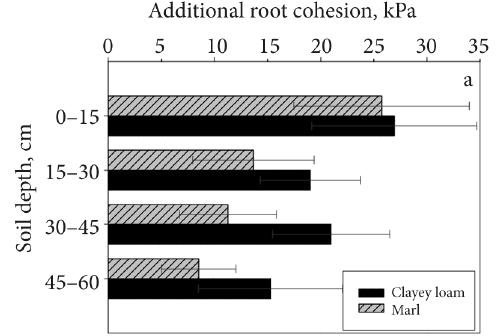
Figure 3. Additional root cohesion in different layers of the soil according to the age of the